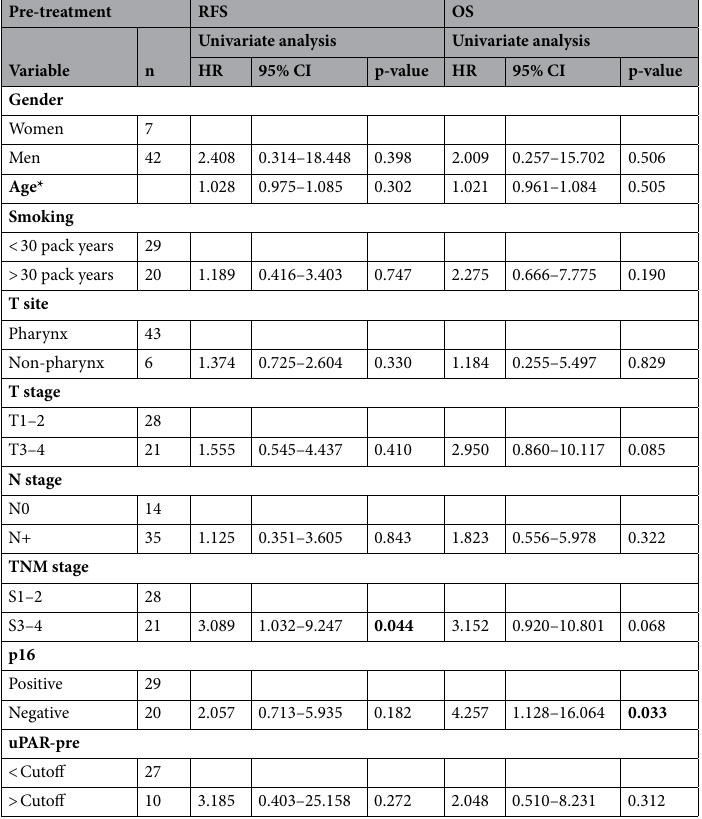
Table 3. Prognostic value of pre-treatment plasma uPAR. Cox proportional hazards model for relapse-free survival (RFS) and overall survival (OS) in relation to clinicopathological variables and pre-treatment plasma uPAR (uPAR-pre) dichotomized according to the established cut-off. Significant values are in [bold]. *Age was included as a continuous covariate. T tumor; N node; M metastasis. Hazards ratio (HR), 95% confidence intervals (95%